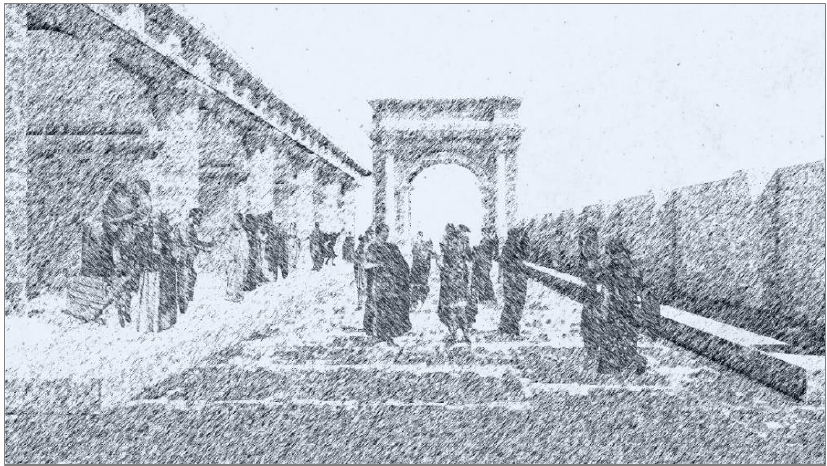
Figure 10 Scene 3: Thematic Reanimation of